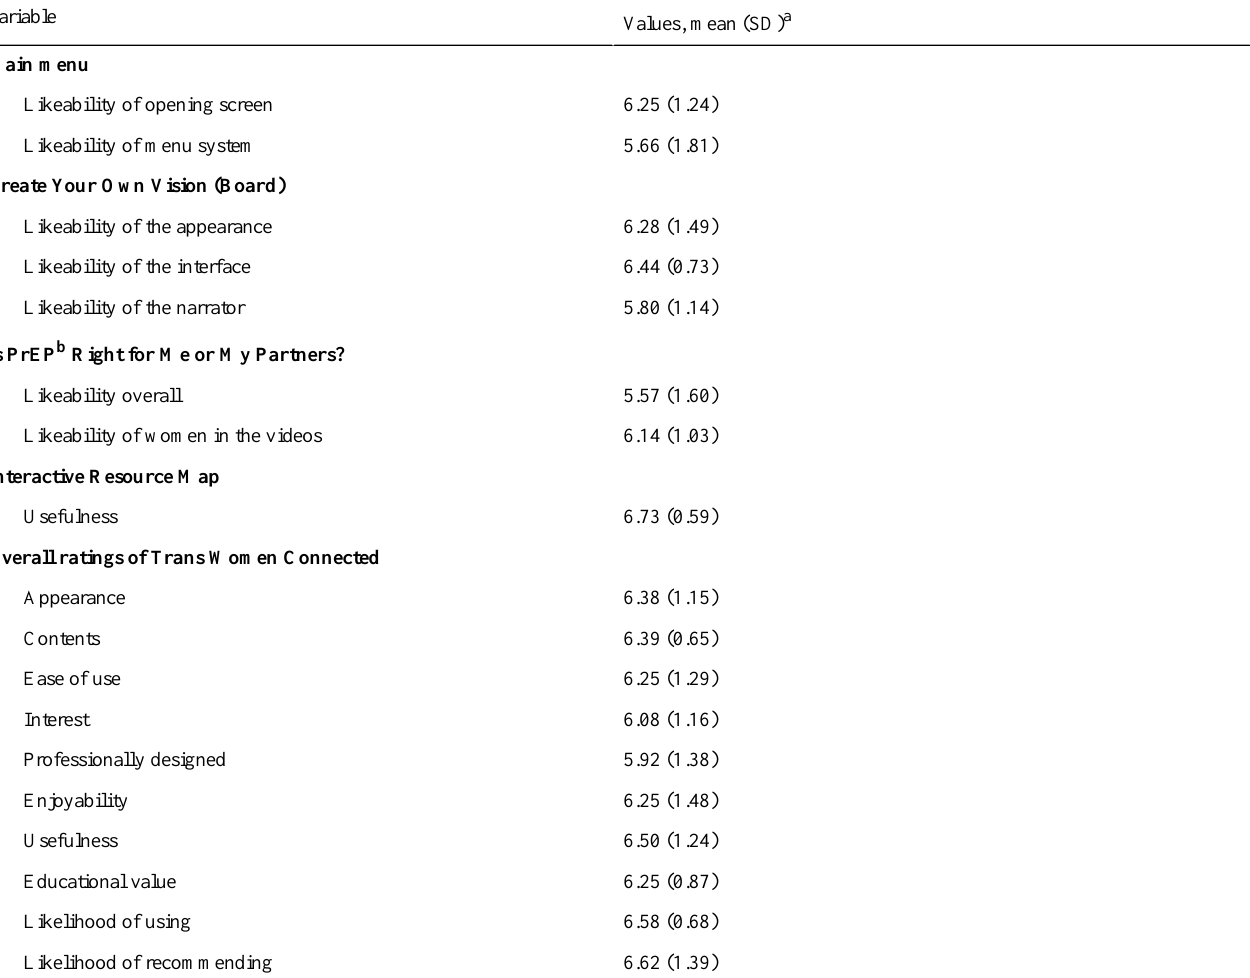
Table 2. Usability and likability ratings of the Trans Women Connected mobile